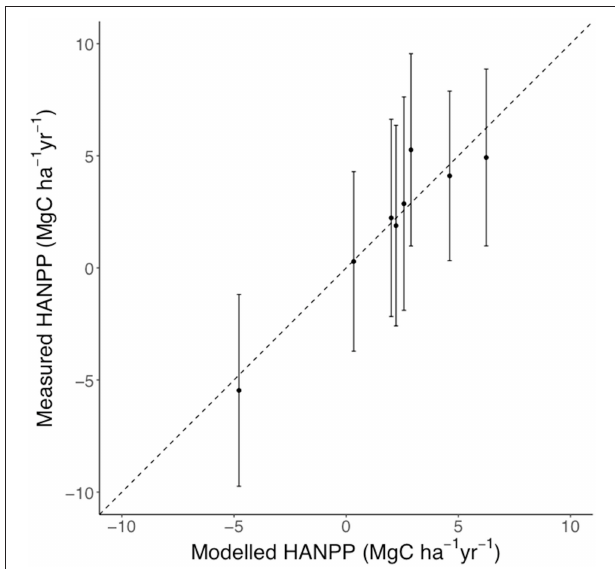
FIGURE 5 | The relationship between measured HANPP and modeled HANPP using cocoa density and shade tree density per hectare as indicators ( r 2 = 0.86). Adapted from Morel et al. (2019).